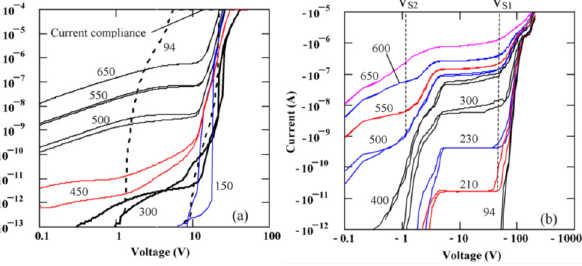
Figure 2. Forward ( a ) and reverse ( b ) I-V characteristics obtained for SI 4H-SiC sample (SI-M50) with 1 mm diameter Ni contact at various temperatures.